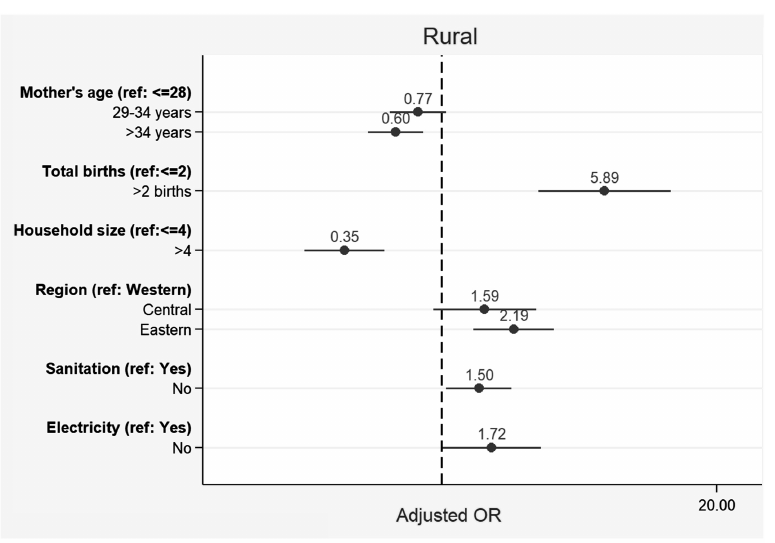
Figure 1. Adjusted association between under-five mortality and the determinants in urban Bhutan